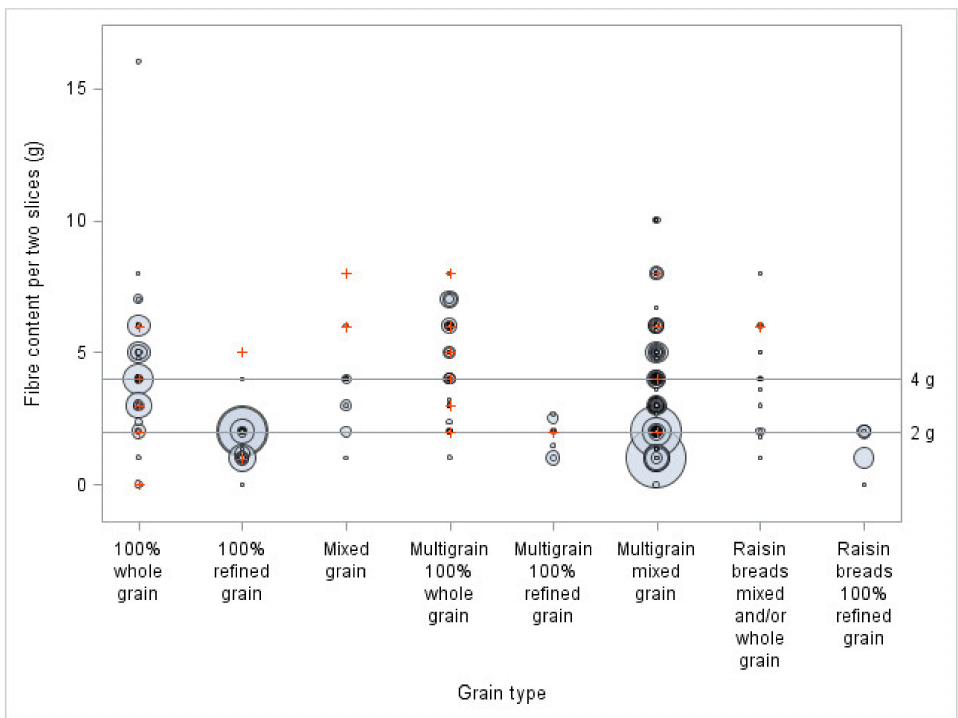
Figure 3. Fibre content of different types of bread and by types of grain and sales volume per two slices ( n = 294), compared to the 2 g and 4 g threshold (8% and 16% of Health Canada DV). The bigger the circles, the higher the sales. Signs + represent sliced bread for which sales data were not available. A portion of 50 g was used when a two-slice portion was inferior to 50